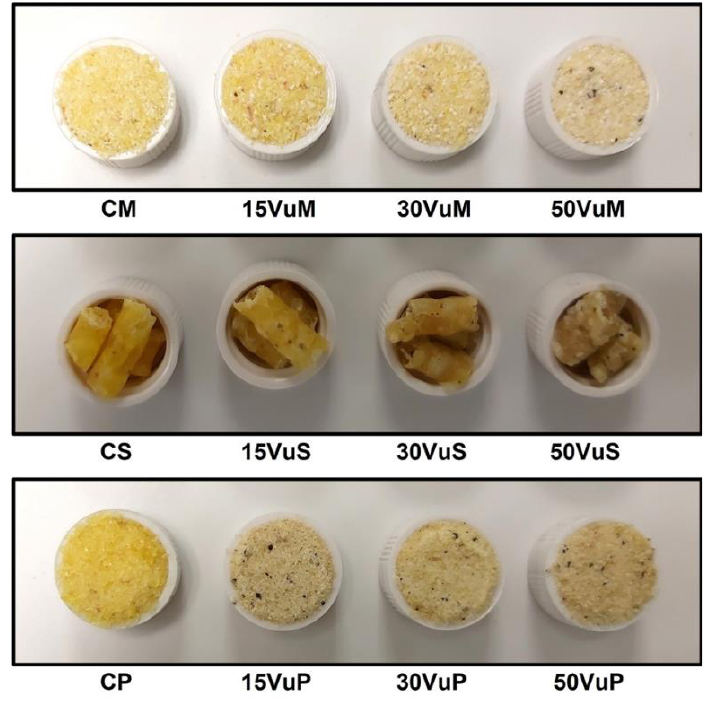
Figure 1. The studied samples. Mixtures (M), pellet sections (S), and powder (P) with different concentrations (15, 30, and 50%) of Vigna unguilata (Vu) and the respective controls (CM, CS, and